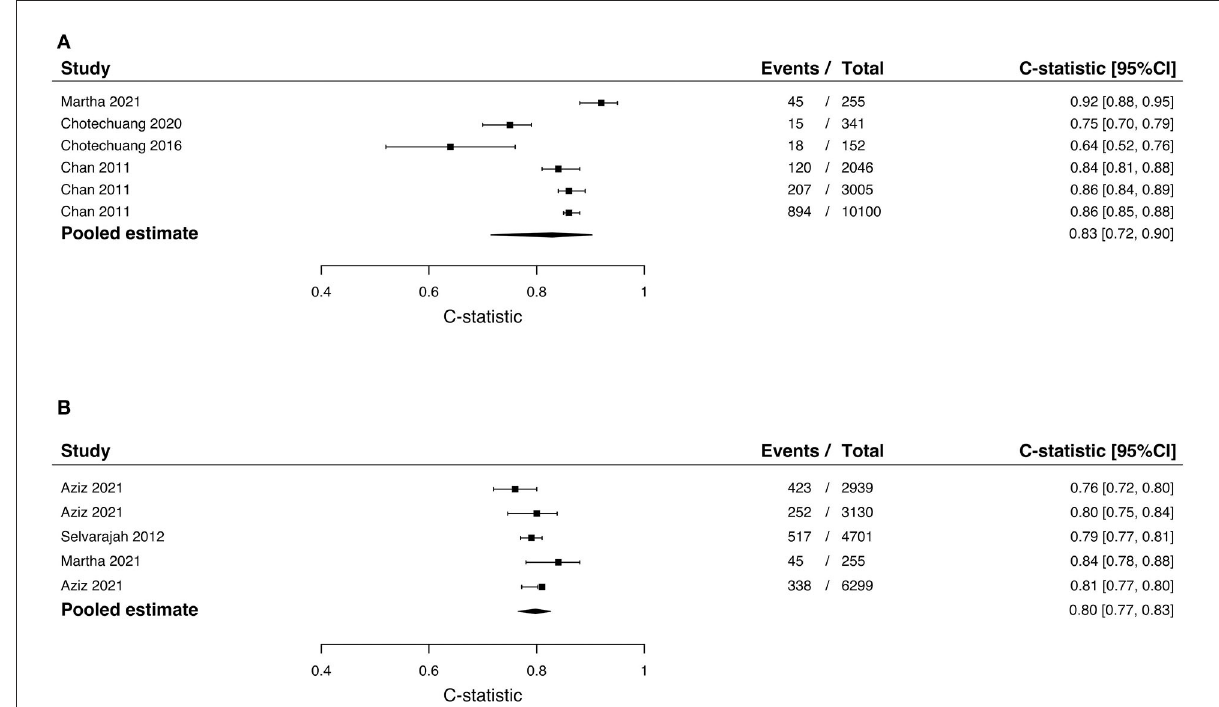
FIGURE2 Meta-analysis of C-statistic for the (A) GRACE score and for the (B) TIMI risk